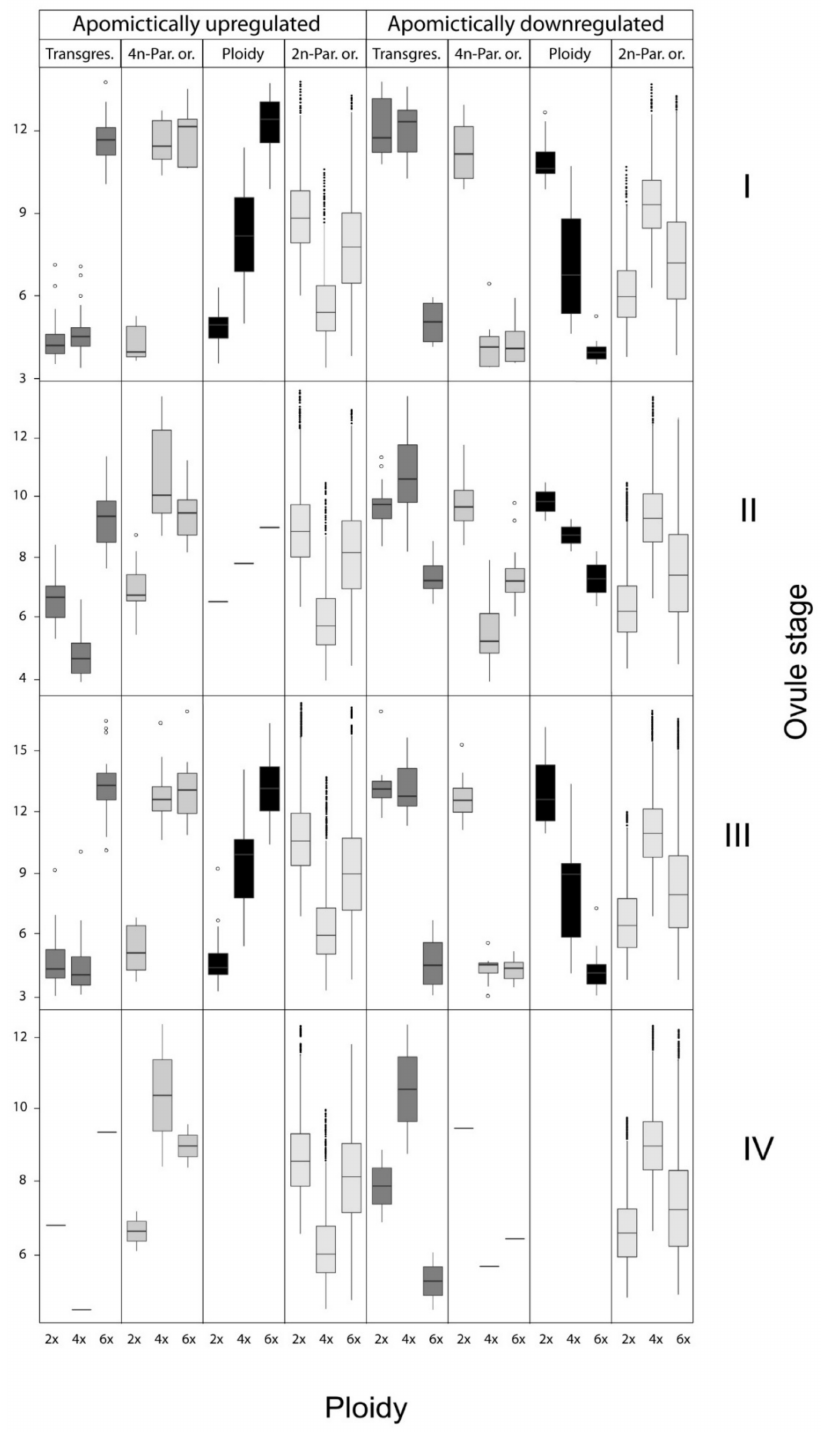
Figure 3. Box plots of expression distributions for genes which were significantly up- or downregulated in at least one apomictic ovule stage, as grouped into transgressive, ploidy-mediated and parent of origin